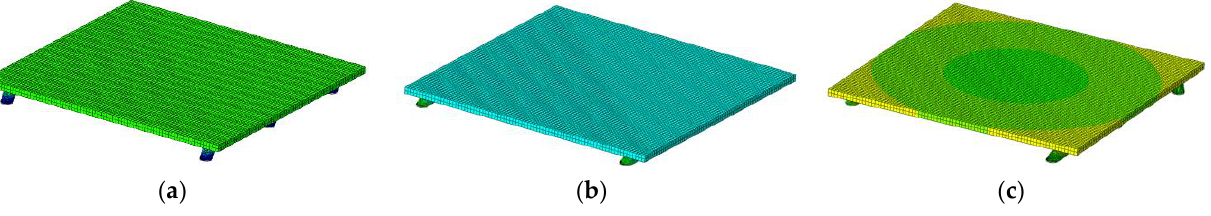
Figure 18. Result of modal analysis for the elastomer spring: ( a ) longitudinal mode; ( b ) transverse mode; ( c ) torsional mode.